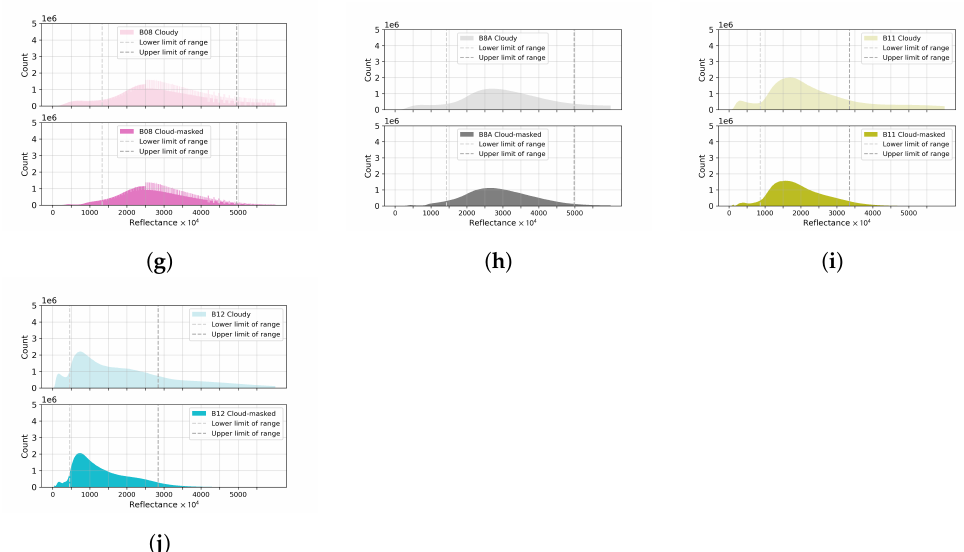
Figure A1. Displacement plots of histograms of all bands from raw BOA Sentinel-2 images before and after cloud masking. Range [1, 6000], bins 1000. ( a ) Band 2. ( b ) Band 3. ( c ) Band 4 (Red).